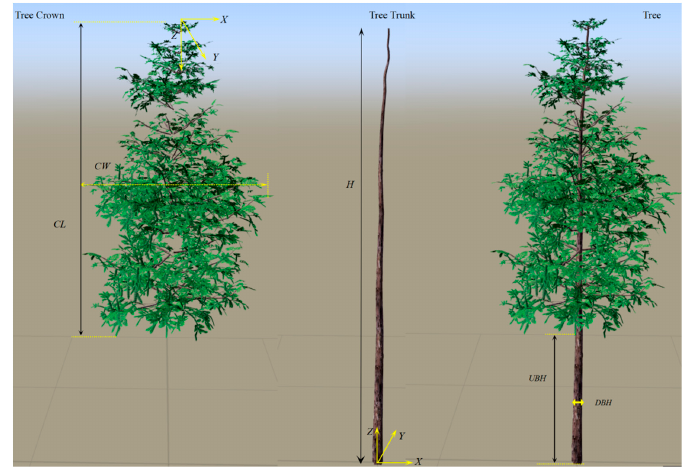
Figure 6. Schematic diagram of fi r split model.